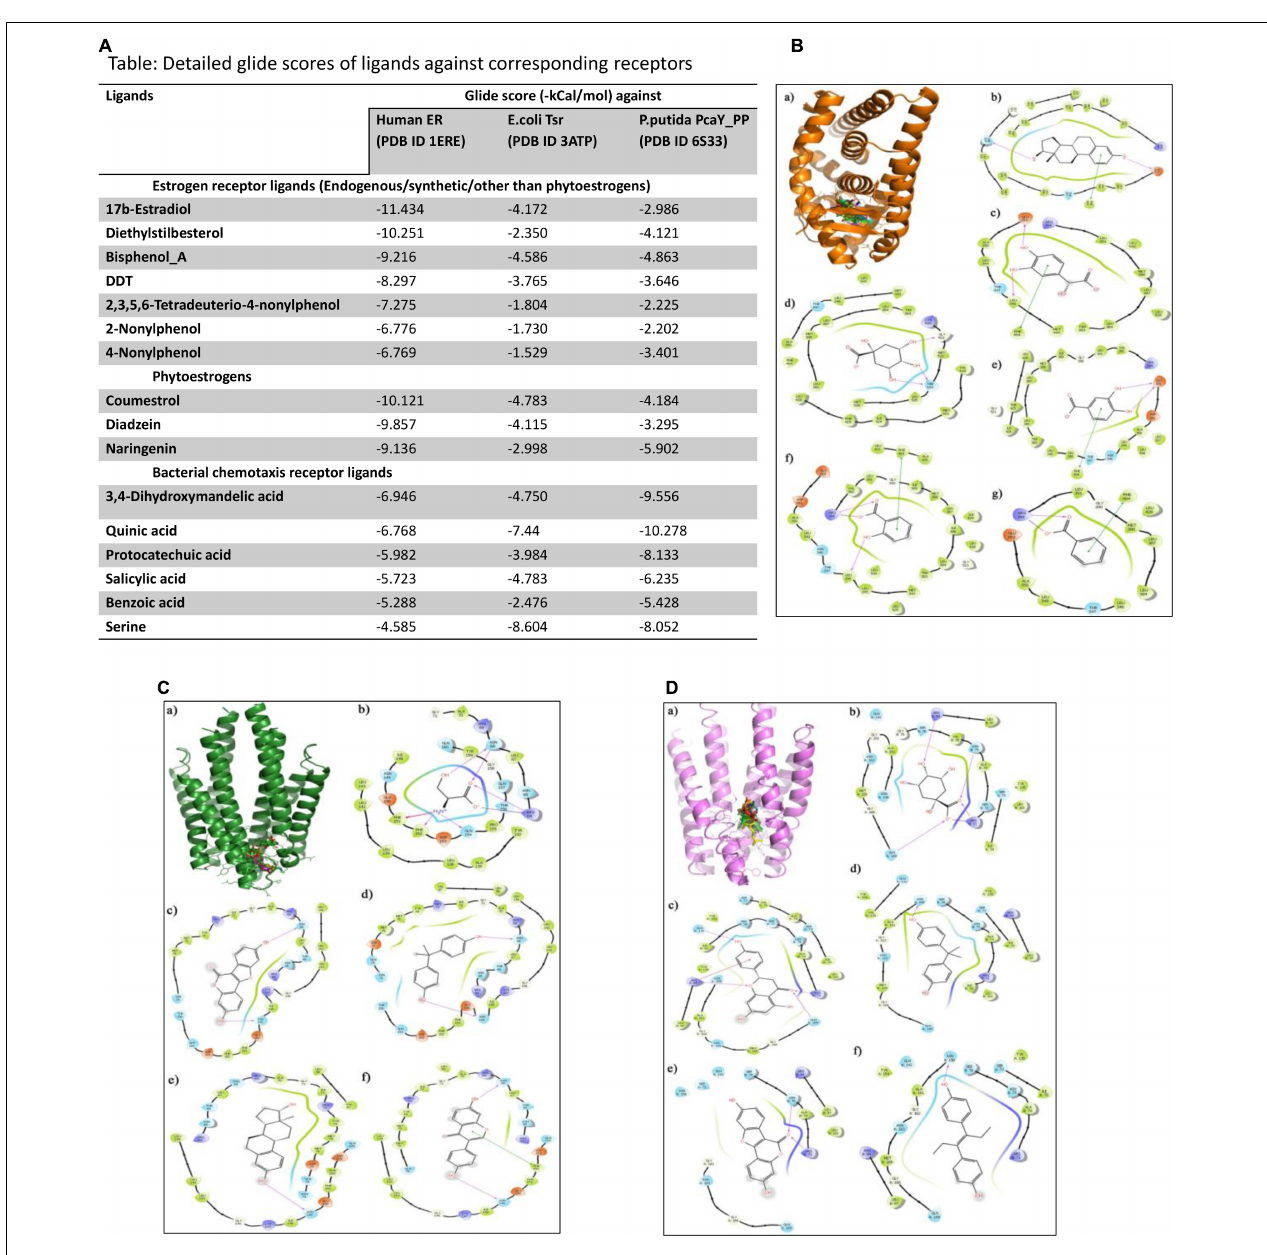
FIGURE 2 | (A) Table representing detailed glide scores of ligands against corresponding receptors. (B) Docking of human ER (PDB ID: 1ERE) with ligands of bacterial chemotaxis receptors. (B.a) Binding of selected ligands in the receptor cavity of human ER (orange, PDB ID 1ERE). (B.b) Ligand interaction diagram of the natural ER ligand 17 β -estradiol with binding site residues of ER. (B.c) Ligand interaction diagrams of the top scoring bacterial chemotaxis ligands 3,4-dihydroxy mandelic acid, (B.d) quinic acid, (B.e) protocatechuic acid, (B.f) salicylic acid, and (B.g) benzoic acid. (C) Docking of E. coli chemotaxis receptor Tsr (PDB ID: 3ATP) with ligands of human ER. (C.a) Binding cavity in the AB chain interface of E. coli chemotaxis receptor Tsr (green) occupied with the reference ligand serine and ER ligands. (C.b) The interaction of serine, (C.c) coumestrol, (C.d) bisphenol A, (C.e) estradiol, and (C.f) diadzeine. (D) Docking of bacterial chemotaxis receptor (PDB ID 6S33) with ligands of human ER. (D.a) . Ligand binding domain in the AB chain interface of P. putida chemotaxis receptor PcaY_PP (violet, PDB ID 6S33) occupied with the reference ligand “quinic acid” and ER ligands. The interaction of (D.b) quinic acid, (D.c) naringenin, (D.d) bisphenol A, (D.e) coumestrol, and (D.f)